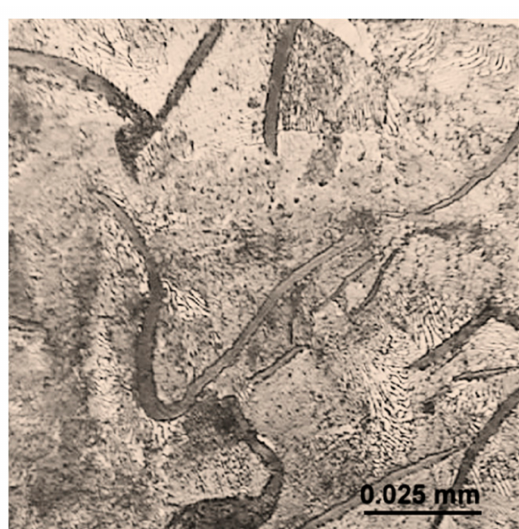
Figure 1. The cultivator coulter.